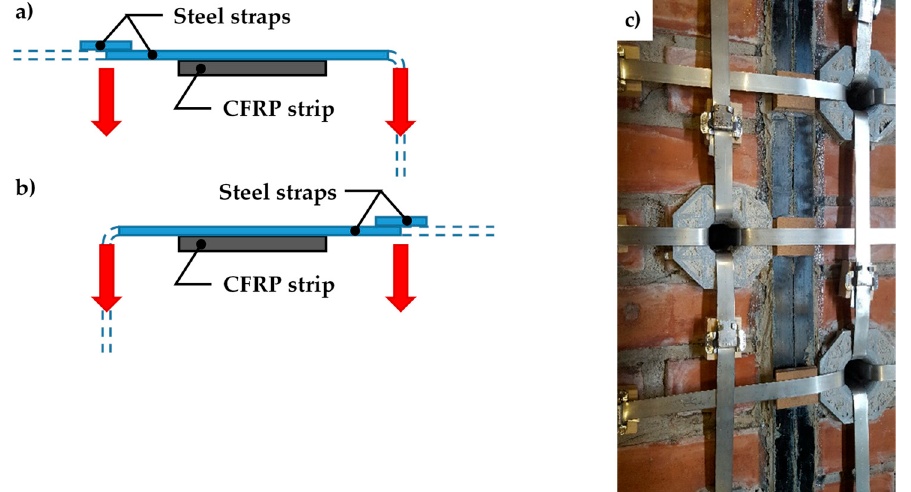
Figure 36. Intersections between longitudinal and transverse straps: ( a ) the longitudinal strap pushes down on the transverse strap to the left of the CFRP strip (cross-section view, not to scale). ( b ) The longitudinal strap pushes down on the transverse strap to the right of the CFRP strip (cross-section view, not to scale). ( c ) Detail of strap arrangement, with scheme sequence a, b, a.